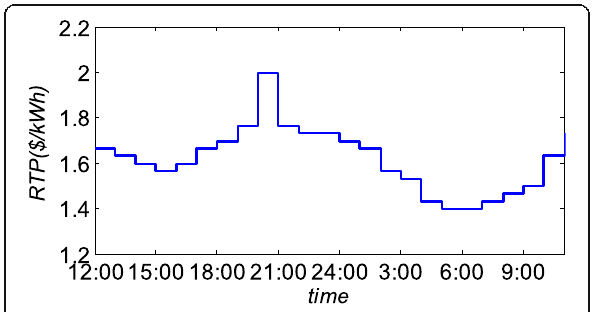
Fig. 6 The adopted RTP scheme in simulations